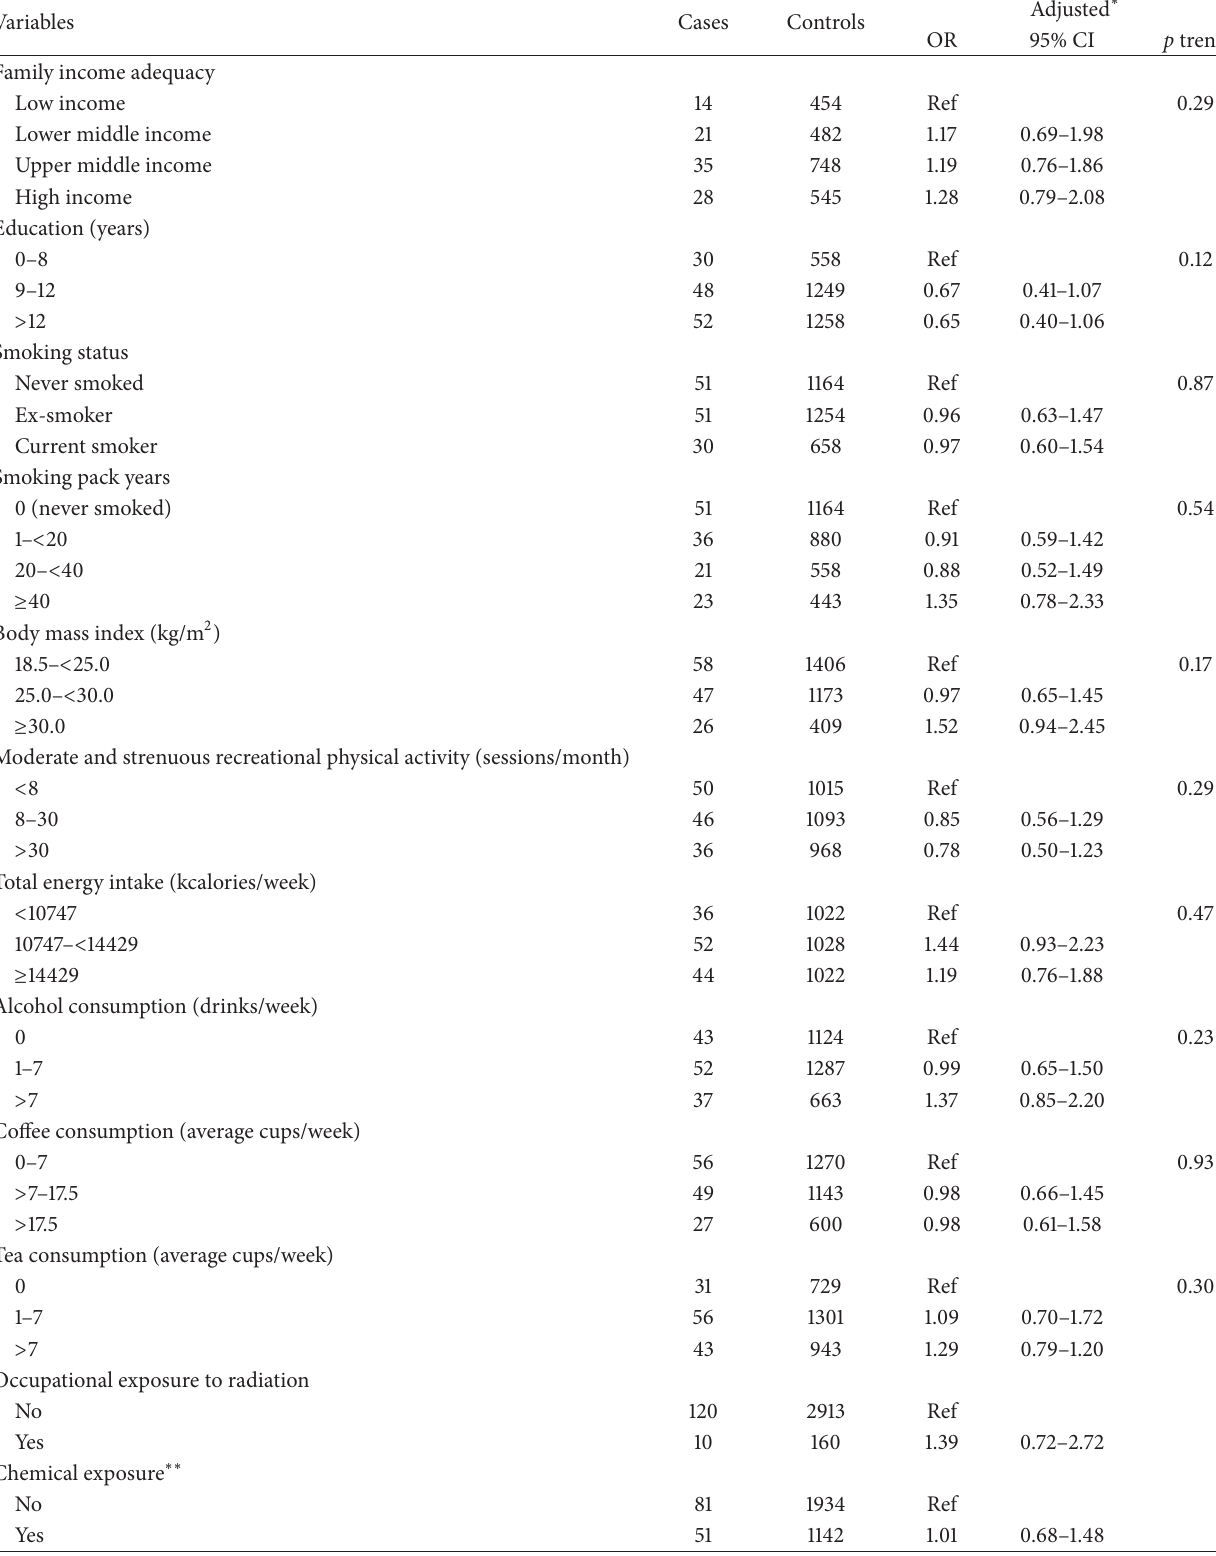
Table 2: Odds ratios (OR) of salivary gland cancer associated with some demographic and lifestyle